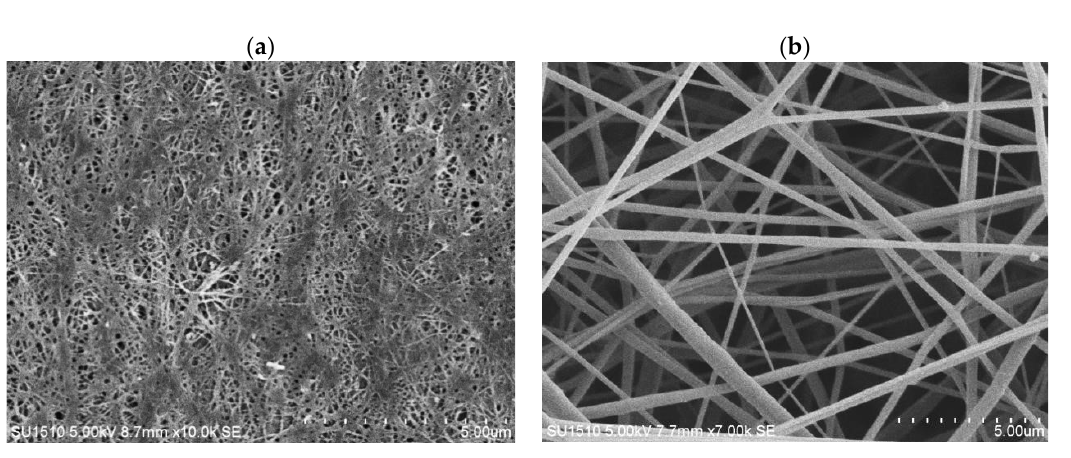
Figure 2. ( a , b ) SEM images for BC film ( a ) and CA-ENMs ( b ) sample surface